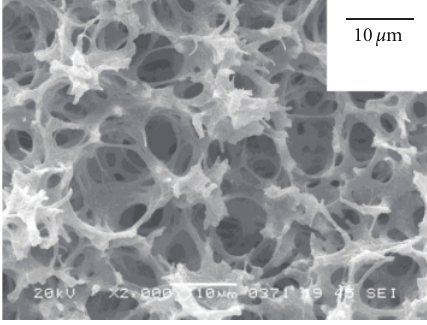
Figure 6: XRD patterns of the EE-EvD, the EE-SCD, and the EE- HyT